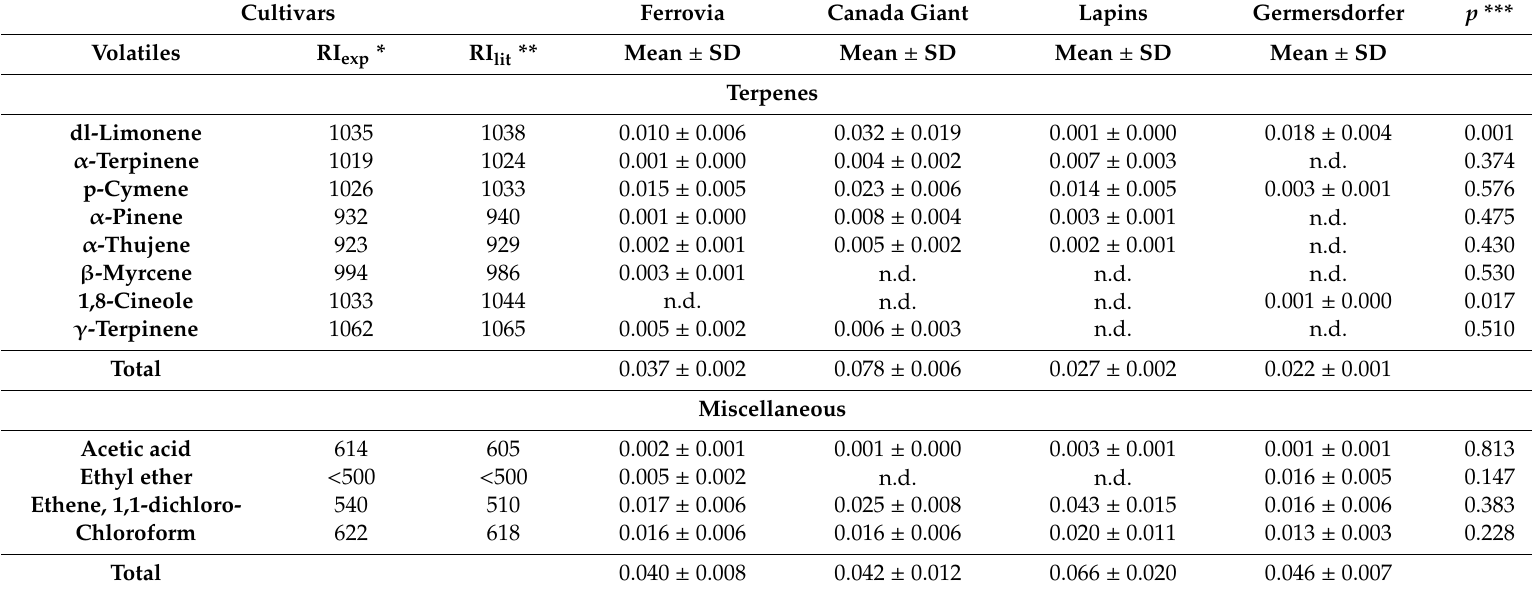
Table 2. Mean values and SD (mg / kg) of volatile compounds of cherry samples